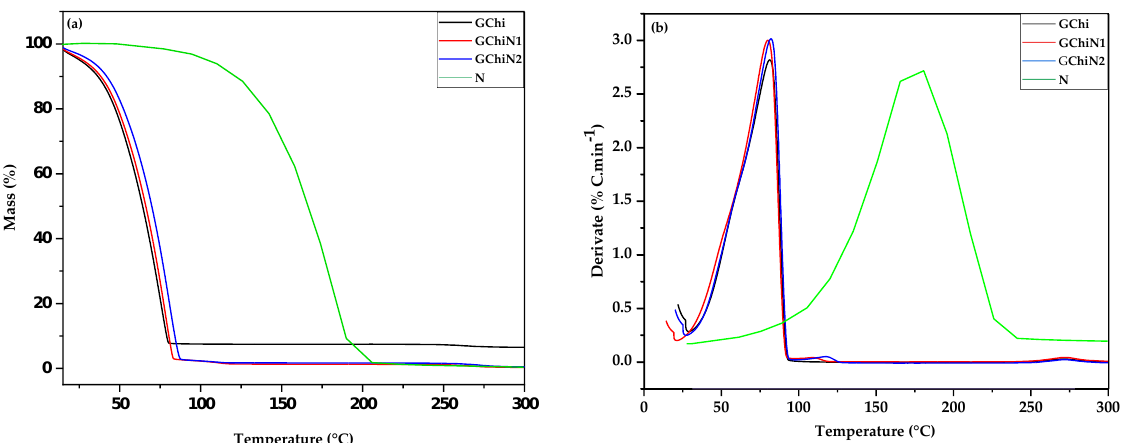
Figure 1. ( a ) TGA curves and ( b ) DTG curves of chicha hydrogel (GChi), nerolidol (N), chicha hydrogel with 0.01 g mL −1 nerolidol (GChiN1), and chicha hydrogel with 0.02 g mL −1 of nerolidol (GChiN2).